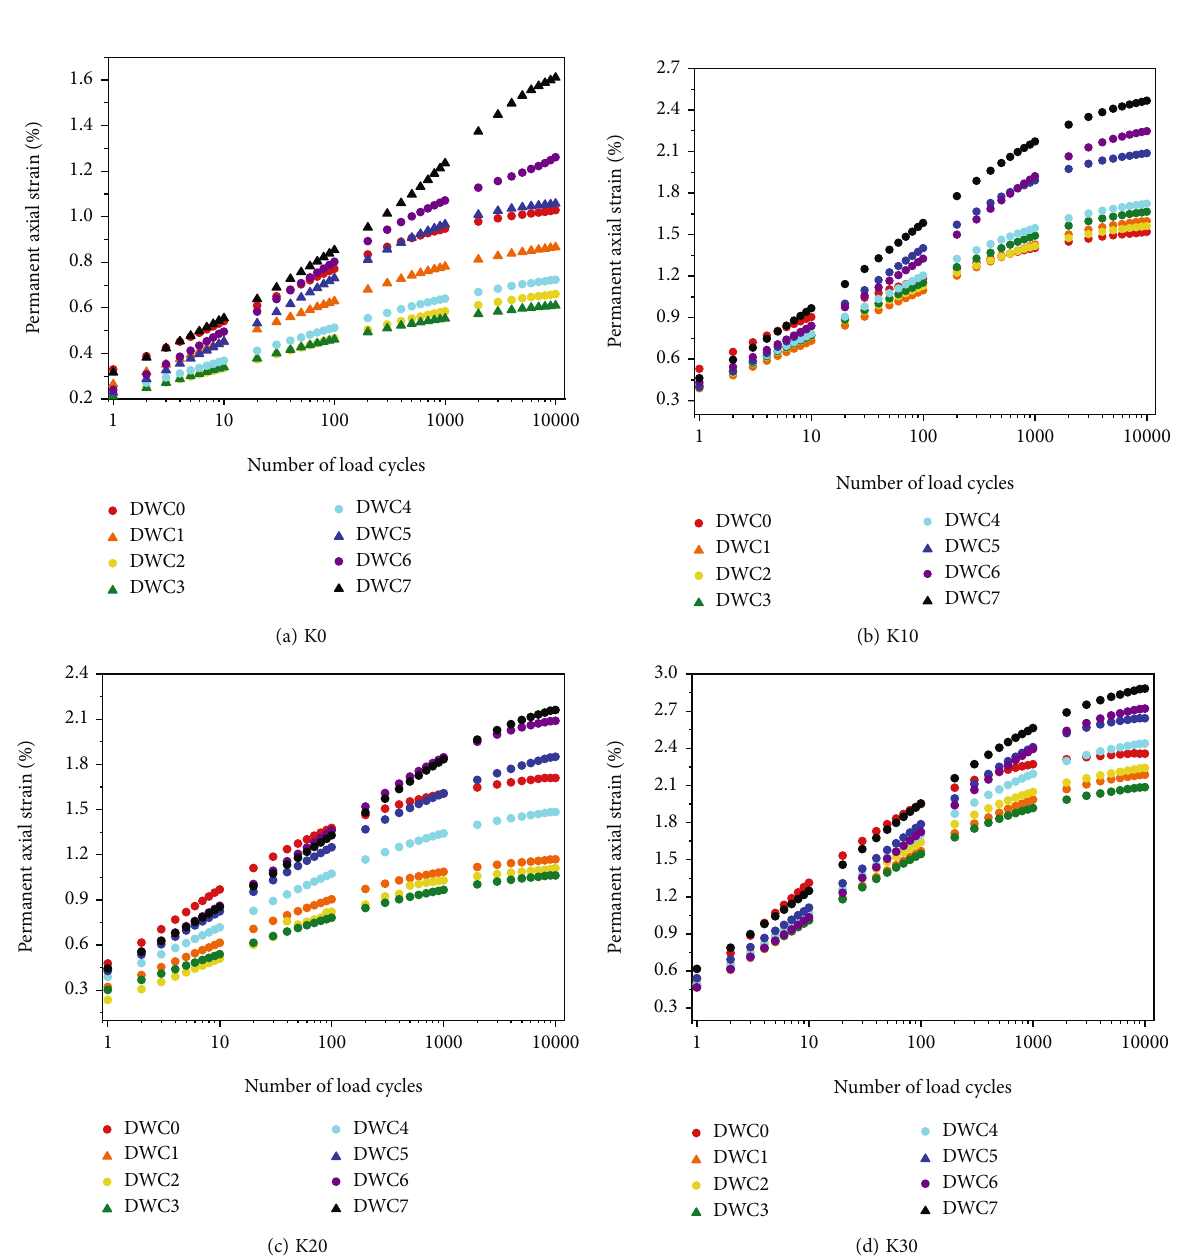
Figure 10: Permanent axial strain of GRS under D-W